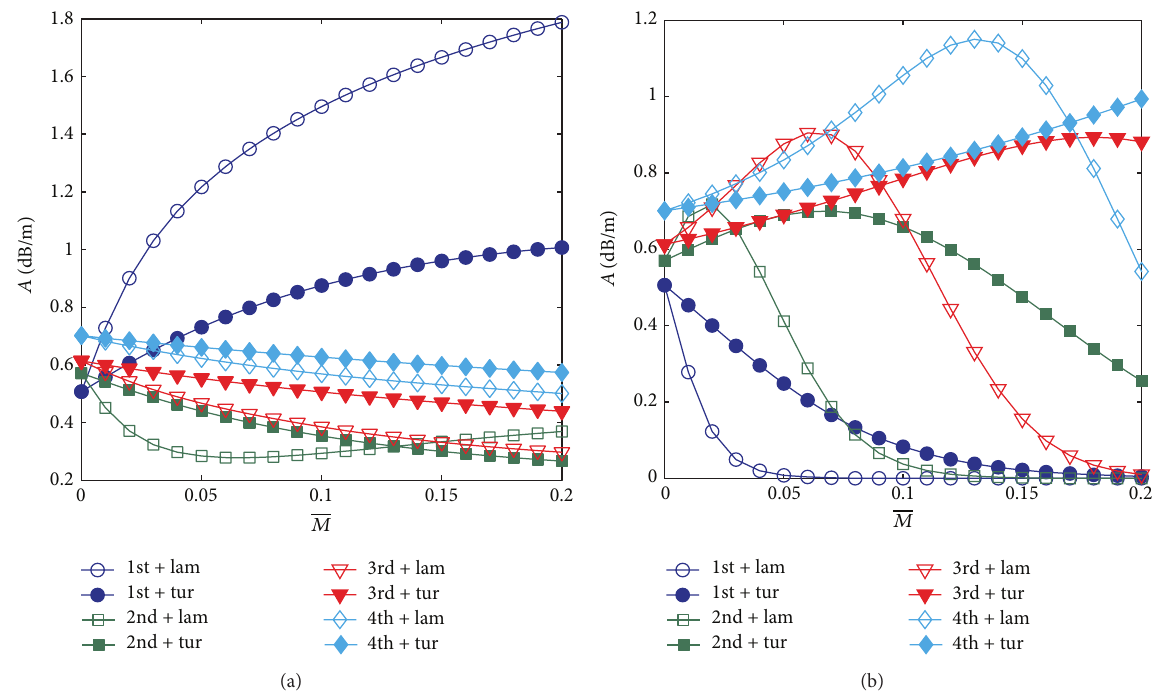
Figure 6: (Color online) Comparison of the attenuation coefficient of the first four axisymmetric modes (“1st,” “2nd,” “3rd,” and “4th”) propagating in the downstream (a) and upstream (b) directions in the laminar (“lam”) and turbulent (“tur”) velocity